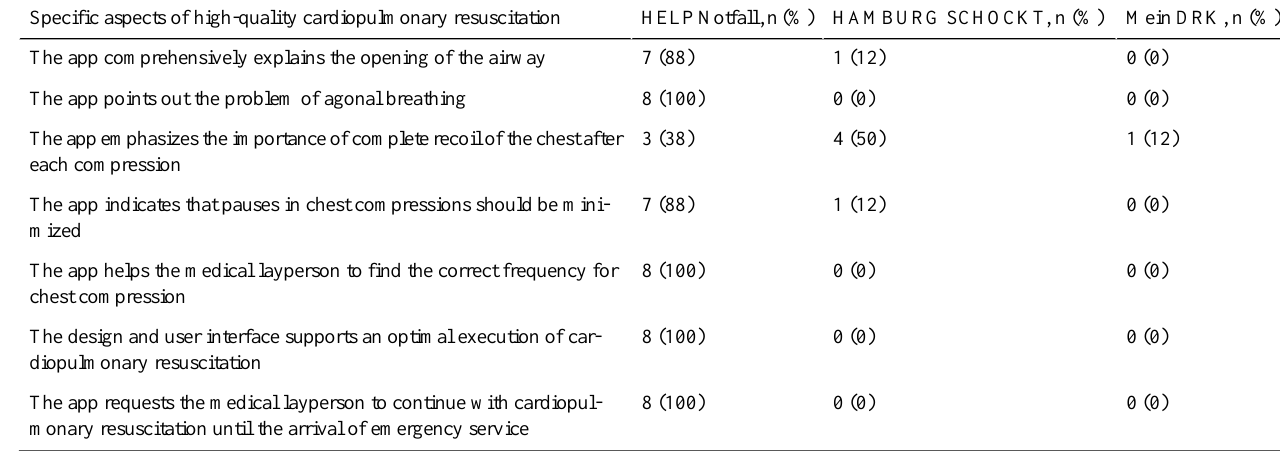
Table 2. Number of emergency physicians rating the app listed as the one teaching a specific aspect of high-quality cardiopulmonary resuscitation best. A total of 8 emergency physicians evaluated the